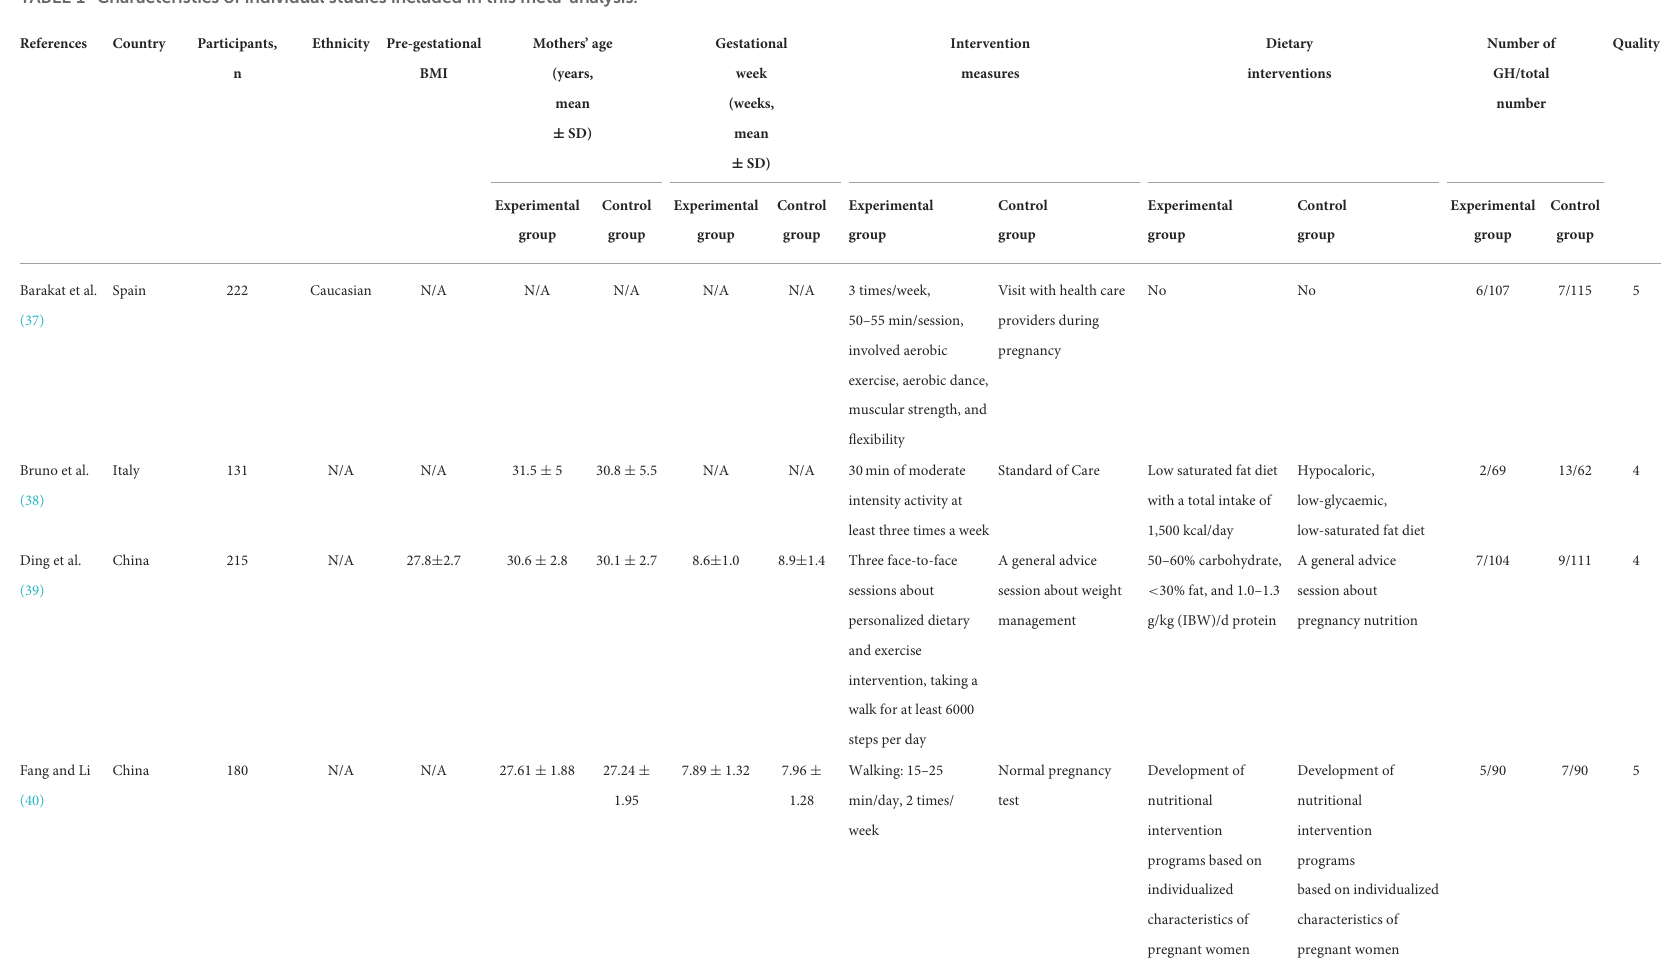
TABLE 1 Characteristics of individual studies included in this